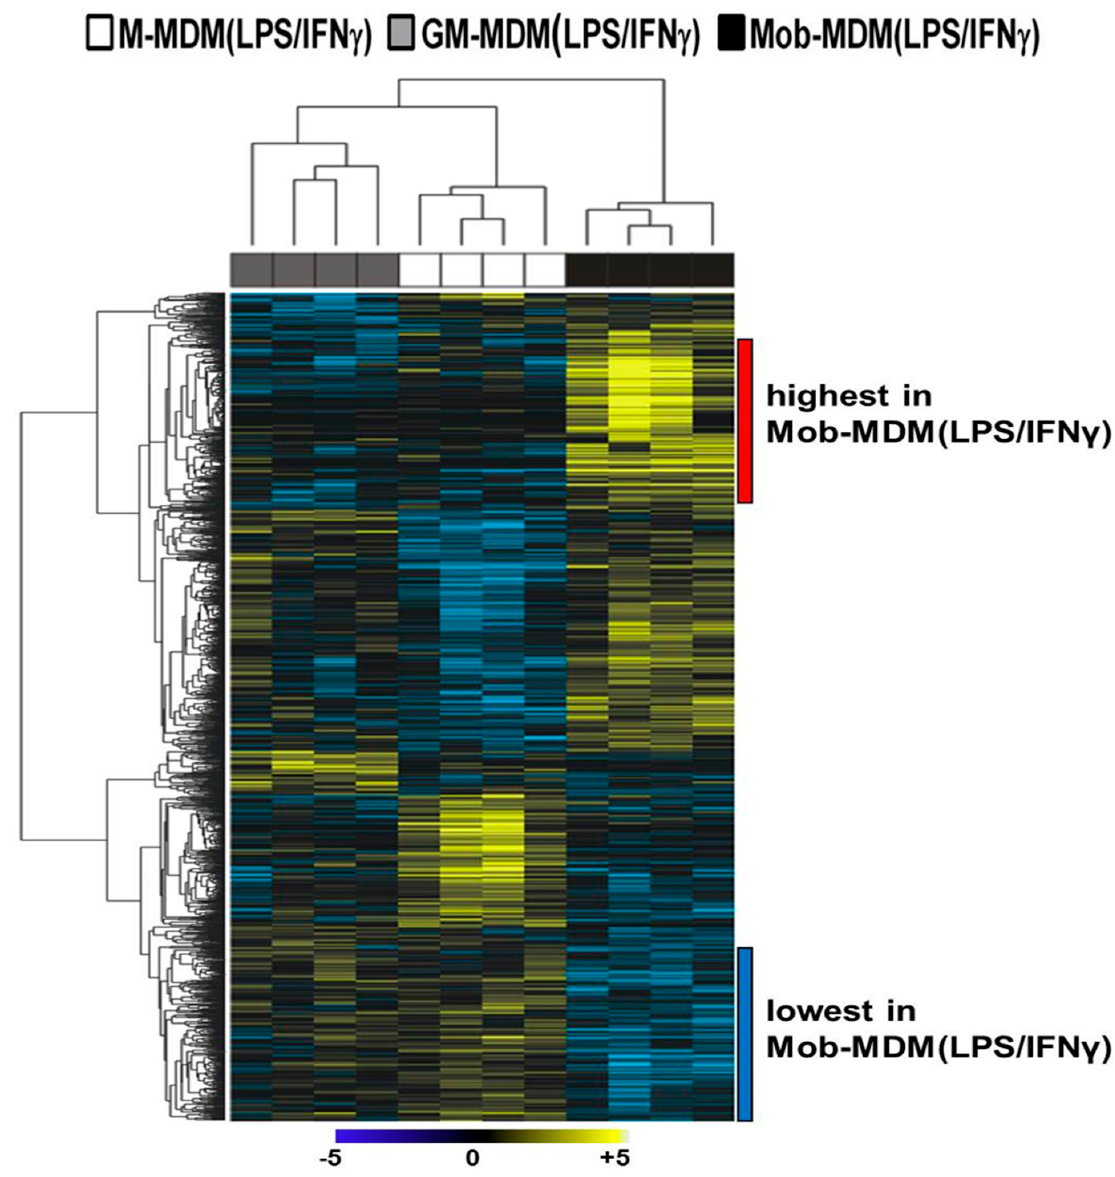
Figure 2. Whole-transcriptome analysis of lipopolysaccharide (LPS)/interferon γ (IFN γ )-activated monocyte-derived